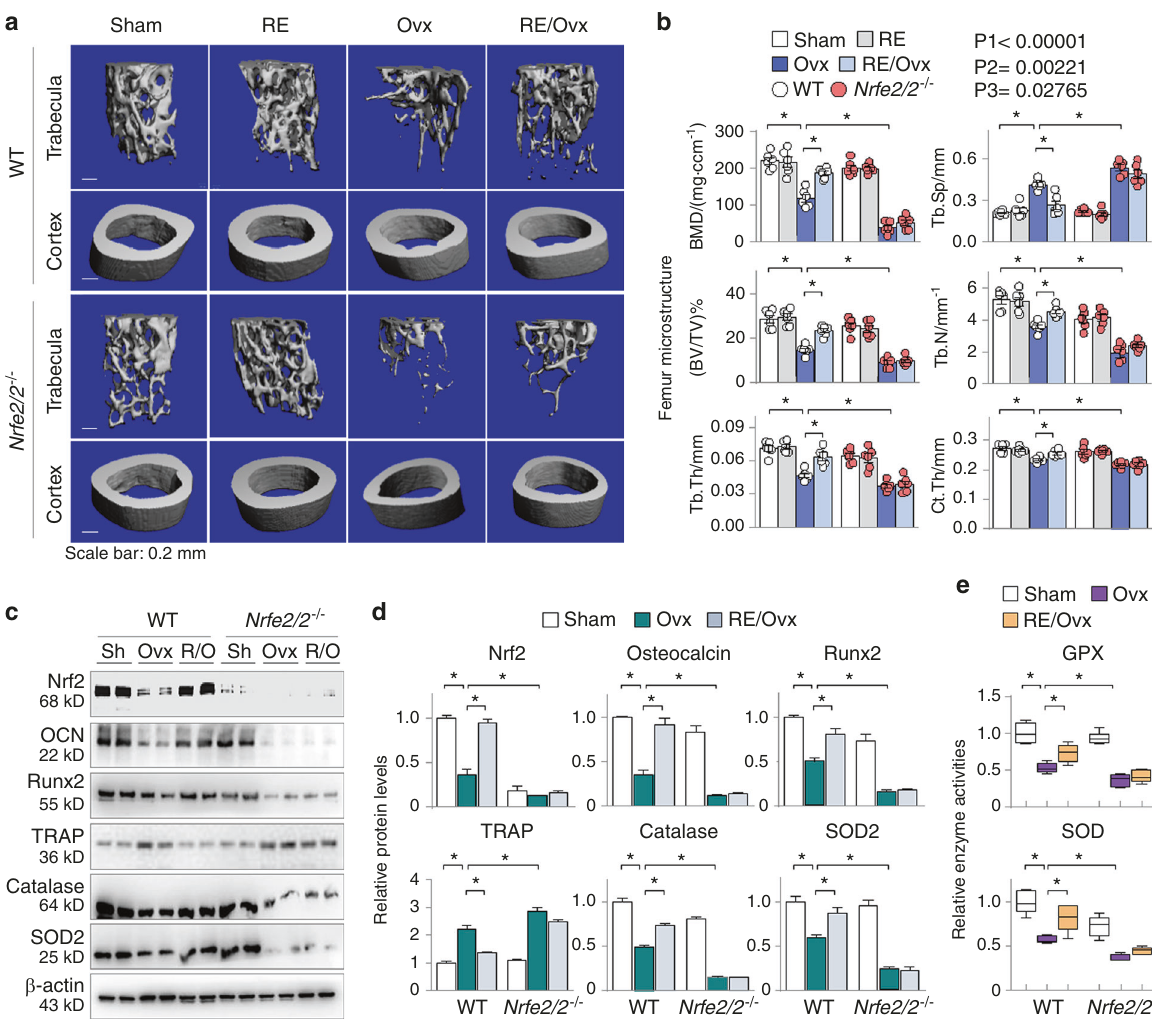
Fig. 6 Nrf2 is essential for the antiosteoporotic effects of running exercise. Nfe2l2 − / − mice and the control littermates (WT) were subjected to the sham, RE, Ovx and RE/Ovx treatments as described in the methods (6 mice in each group). a Representative photomicrographs of micro- CT-scanned femoral trabeculae and cortex. b Quantitation of the samples in Fig. 6a. BMD (mg·ccm − 1 ), the ratio of bone volume to tissue volume (BV/TV), trabecular number (Tb.N), trabecular thickness (Tb.Th), trabecular separation (Tb.Sp) and cortical thickness (Ct.Th) were assessed. * P < 0.05, three-way ANOVA with Tukey ’ s post hoc test. P values for the effect of genotype (P1), running intervention (P2), and the interaction between genotype and running intervention (P3) are indicated. c Western blotting of femoral Nrf2, osteocalcin (OCN), Runx2, TRAP, catalase and SOD2. Two representative samples from each group are shown. d Quanti fi cation of the samples in Fig. 6c. e The enzyme activities of GPX and SOD were examined in mouse femoral homogenates. d and e Data are presented as the mean ± SEM of all experimental mice. * P < 0.05, two-way ANOVA with Tukey ’ s post hoc